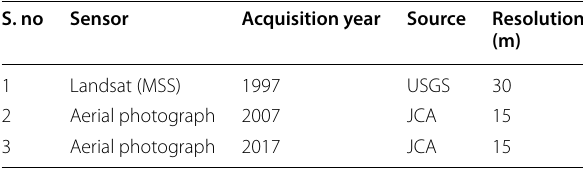
Table 2 Imagery data used for the